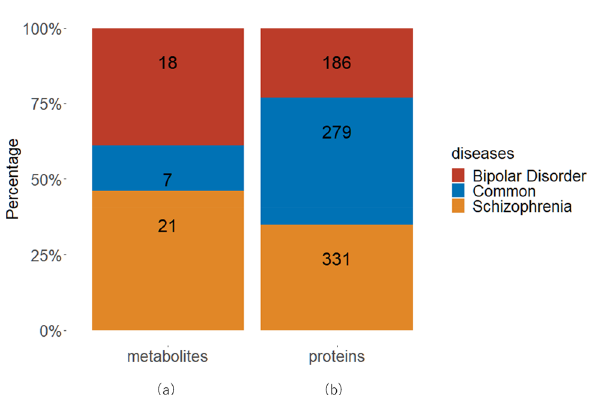
Figure 2. Proportion of unique and common ( a ) metabolites, ( b ) proteins regarding schizophrenia (SCZ) and bipolar disorder (BD). The metabolites and proteins present in BD, SCZ and common to both diseases are indicated by red, orange and blue colors